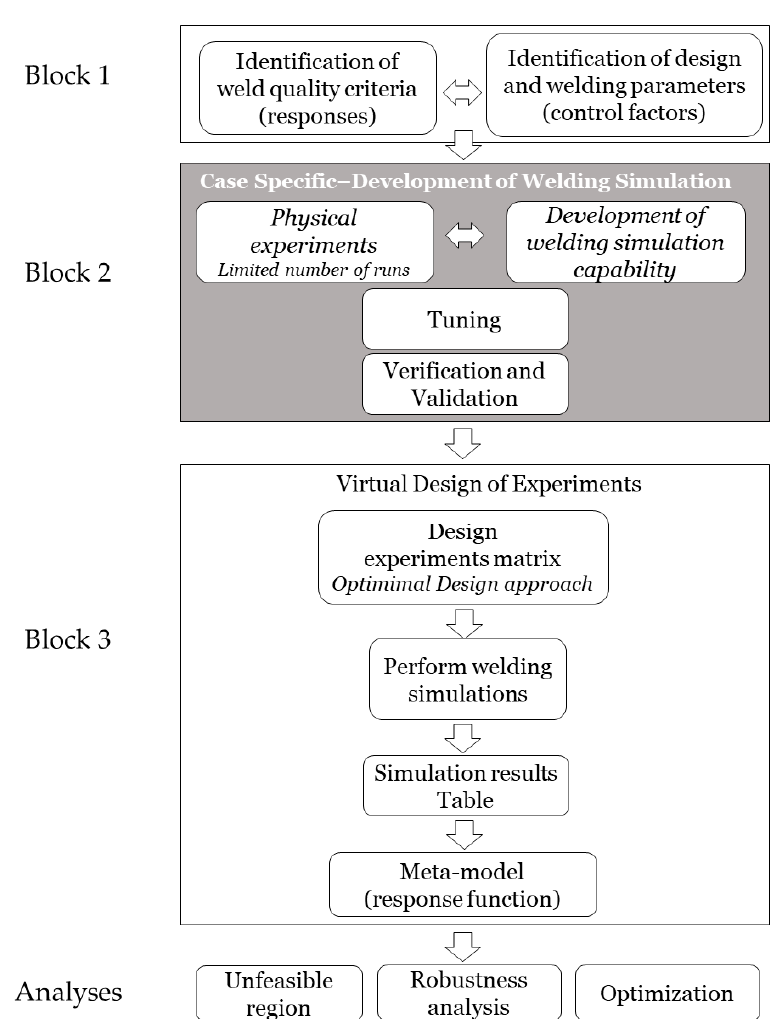
Figure 1. Virtual design of experiments method to optimize design and welding parameters.